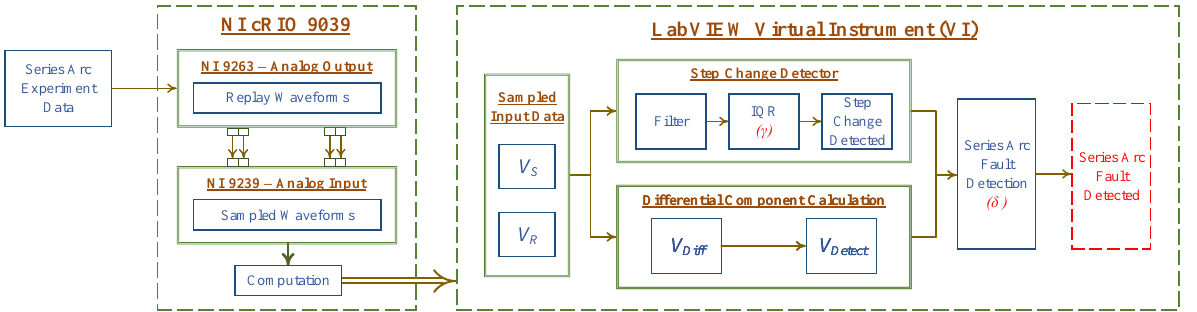
Figure 3. Setup using an embedded controller to demonstrate the proposed